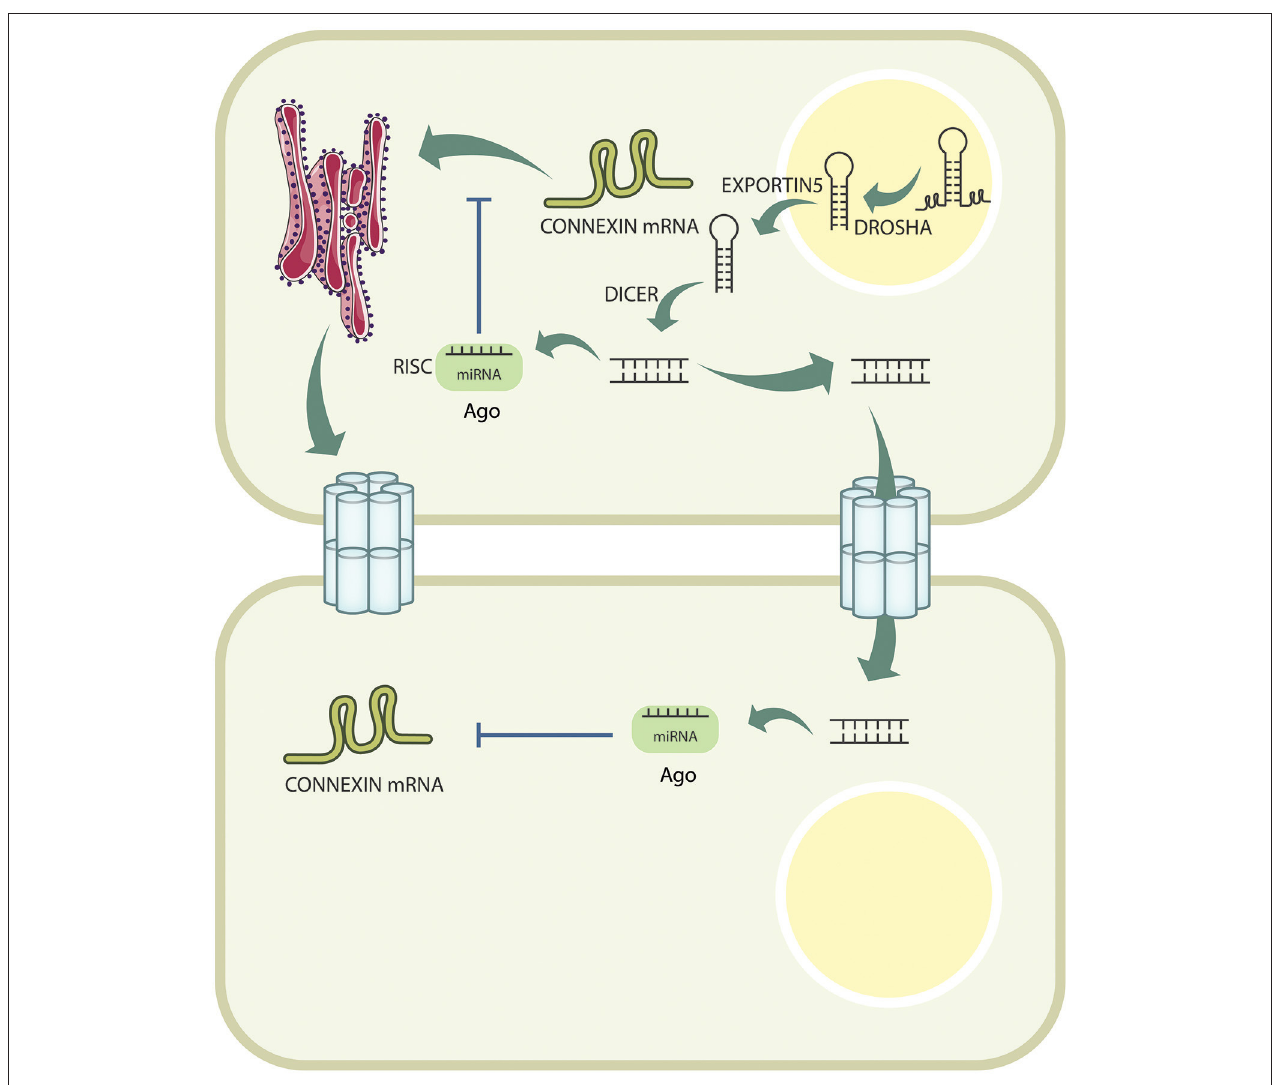
FIGURE 1 | Connexin expression is actively downregulated by miRNAs intracellularly. miRNAs are transcribed in the nucleus, and are processed by DROSHA, before being exported to the cytoplasm by EXPORTIN5. Once exported, they are further cleaved by DICER, and loaded onto the AGO protein to form the RISC complex, which will bind to the Cx mRNA, and target it for degradation. Additionally, pre-miRNAs can pass from cell to cell through GJCs, and exert their effect in neighboring